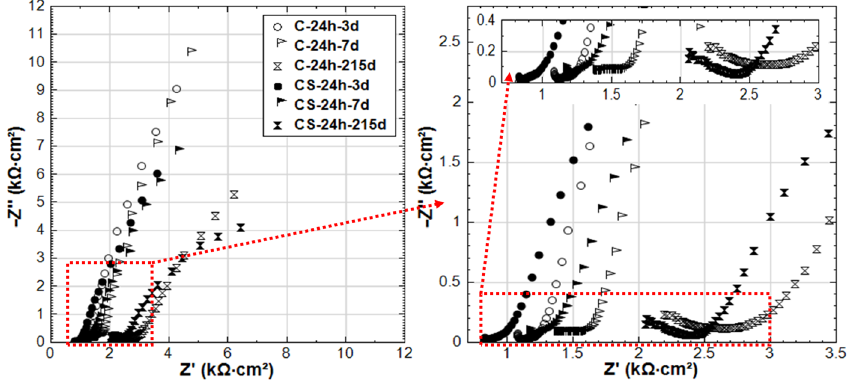
Figure 10. EIS responses overlay in Nyquist format of C-24h and CS-24h (C-24h: NaCl medium, CS-24h: NaCl + Stray Current, 24h-cured specimens treated in 5% NaCl).